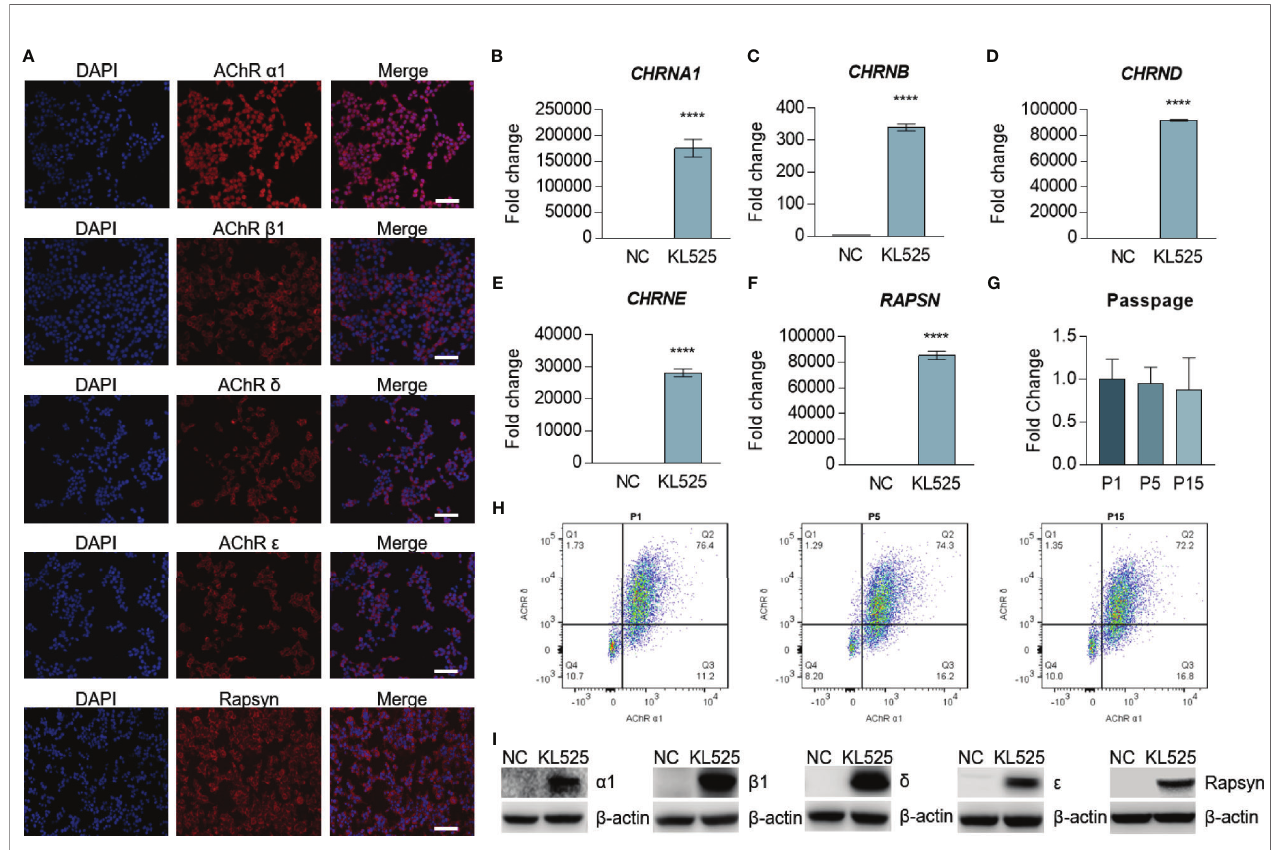
FIGURE 2 | Stable expression of AChR subunits and rapsyn in HEK293T cells. (A) Double immuno fl uorescence staining with 4 ′ ,6-diamidino-2-phenylindole (DAPI, blue), AChR subunits (red) and rapsyn (red) in the stable cell line KL525. Bar, 100 m m. (B – F) mRNA expression of the human AChR subunit genes CHRNA1 , CHRNB , CHRND and CHRNE and the AChR-clustering protein gene RAPSN in KL525 cells, as measured by real-time PCR. Uninfected HEK293T cells were used as the negative control (NC). (G, H) Flow cytometric analysis and representative results of coexpression of the AChR a 1 & d subunits in KL525 cells after passage. (I) Western blot analysis of AChR a 1, b 1, d , ϵ subunits and rapsyn. Uninfected HEK293T cells were used as the NC. ****P < 0.0001 compared with